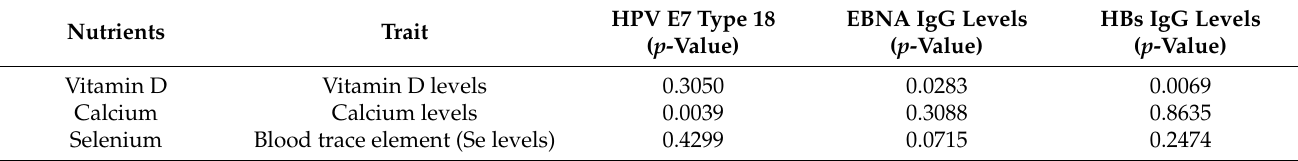
Table 2. 2SMR results for nutrients and indicator levels of viral infections.